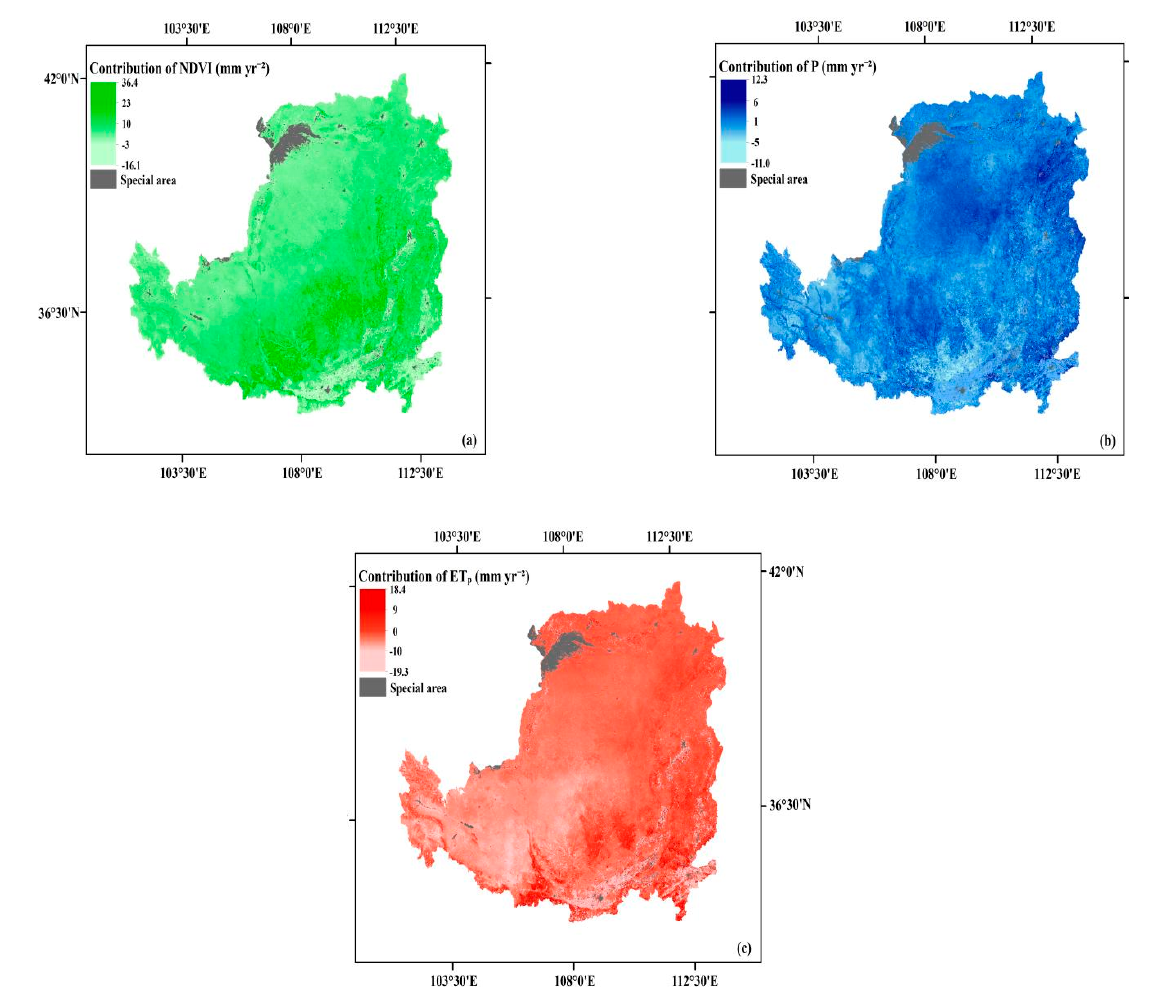
Figure 10. Contributions of vegetation greening (NDVI) ( a ), precipitation variation (P) ( b ), and ET p variation ( c ) to the trend of ET a .